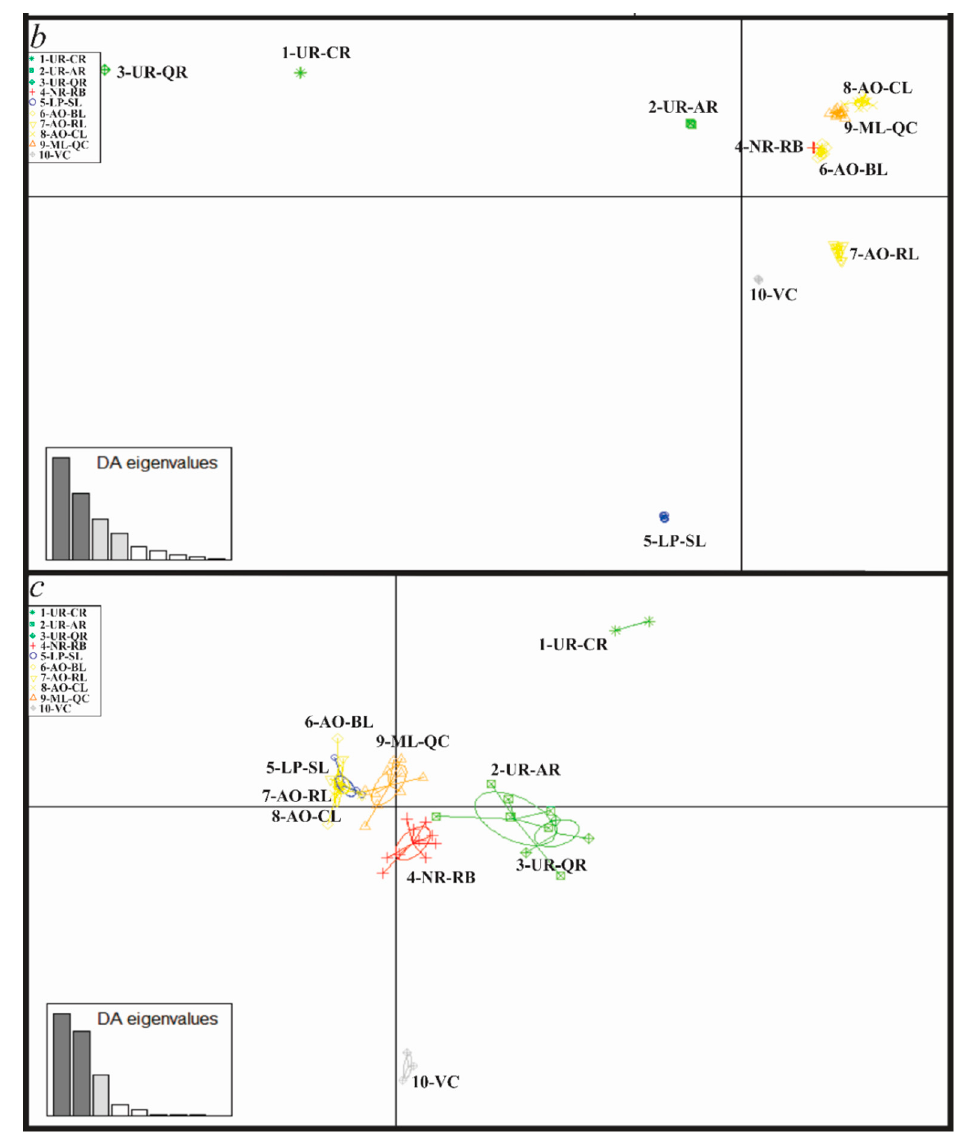
Figure 2. DAPC (Discriminant Analysis of Principal Components) scatterplot of Rhamdia quelen from the La Plata Basin, the Patos-Merin Basin system and the coastal lagoons draining to the SW Atlantic Ocean based on Total 17,559 ( a ), Neutral 15,584 ( b ) and Outlier 73 ( c ) loci. Individuals are grouped per locality (Figure 1). Eigenvalues containing, respectively, 90%, 90 % and 99 % of the cumulative variation of the data are displayed on the right or left bottom boxes. Colors refer to different basins as follows: Uruguay (green), Negro (red), La Plata (blue), Atlantic Ocean (yellow) and Merin Lagoon (orange). The hatchery sample is in gray.